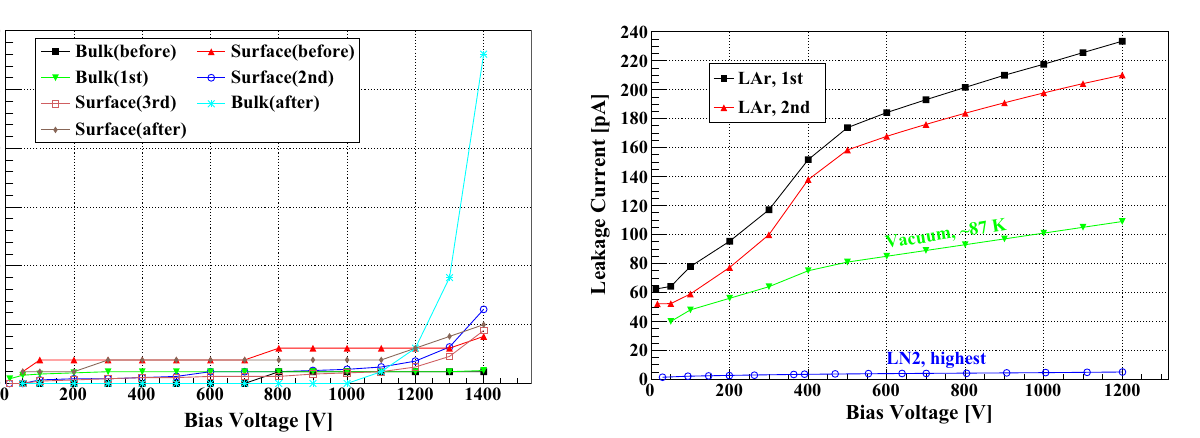
Fig. 13 Leakage currents of detector USD-RL versus its bias voltage in LAr. The numbers denote individual thermal cycles. Also plotted are the highest leakage current measured with the same detector in LN 2 and the one measured in the vacuum cryostat at USD after its deployment at